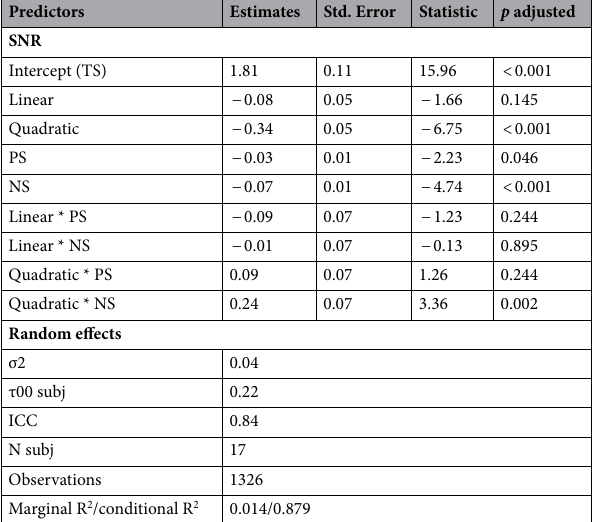
Table 2. Final model parameters for suffixes. Factors were dummy coded with truly suffixed as reference level, using polynomial interpolation. Note that the b -coefficient (estimates) represents the adjustment with respect to the reference level. TS truly suffixed, PS pseudo-suffixed, NS